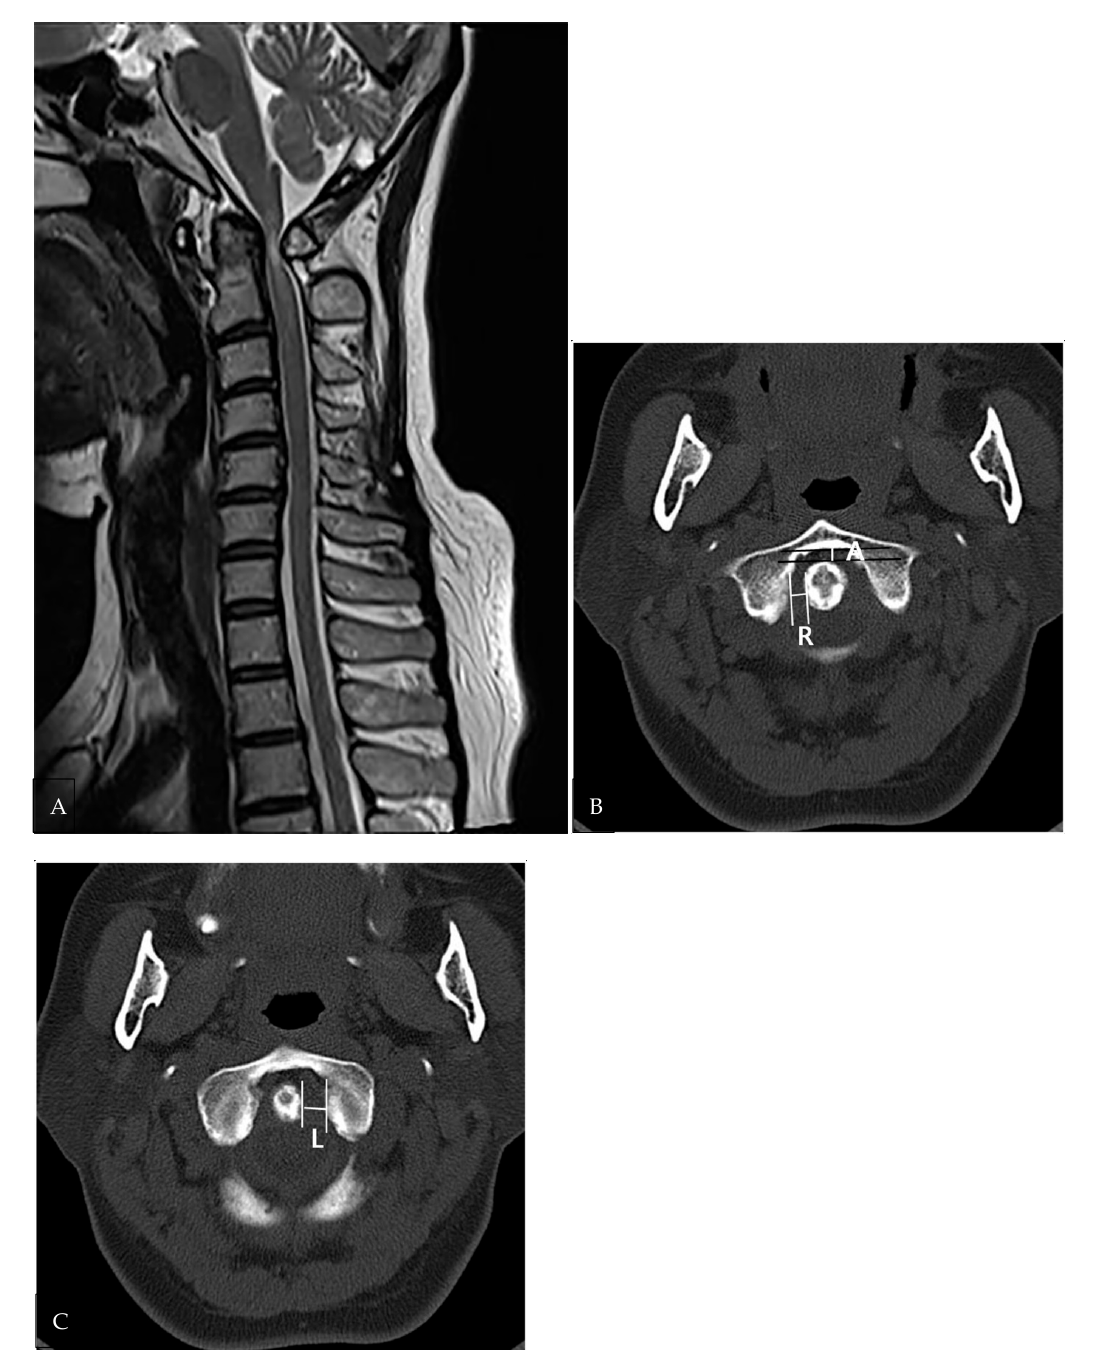
Figure 3. A 58-year-old female patient with rheumatoid arthritis. ( A ) The atlantoaxial joint space represents abnormal widening on sagittal T2WI. The spinal cord of the C1-2 level demonstrates compression and myelopathy, although retro-odontoid soft tissue shows mild thickening. ( B , C ) Each right (R in ( B )) and left gap (L in ( C )) between the odontoid process and lateral mass of C1, as well as the central gap (A in ( B )) between the anterior arch of C1 and the odontoid process of C2 was evaluated for lateral and anteroposterior atlantoaxial joint subluxation. The measurement was performed in the slice at the C1-2 level at the anterior arch of C1, and the odontoid processes of C2 are shown side by side and were measured using axial computed tomography (CT)